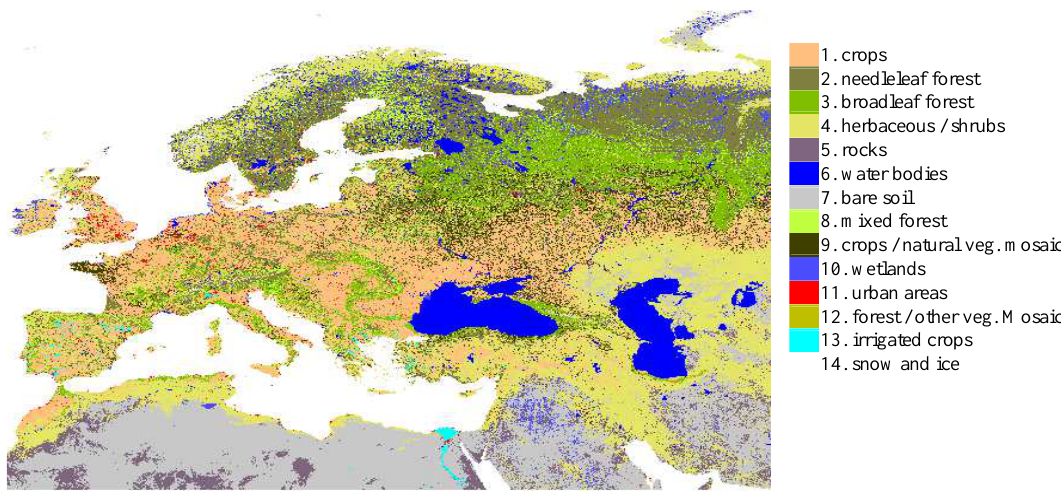
Fig. 2. Classification map with 14 main land covers (C14) resulting from the combination of CLC2000 and GLC2000.